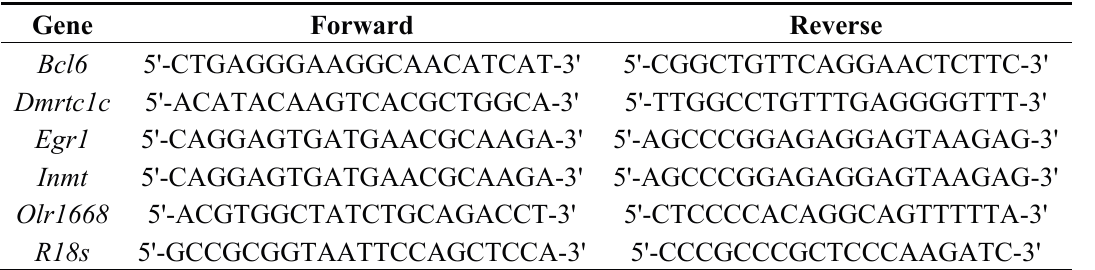
Table 2. qPCR primers